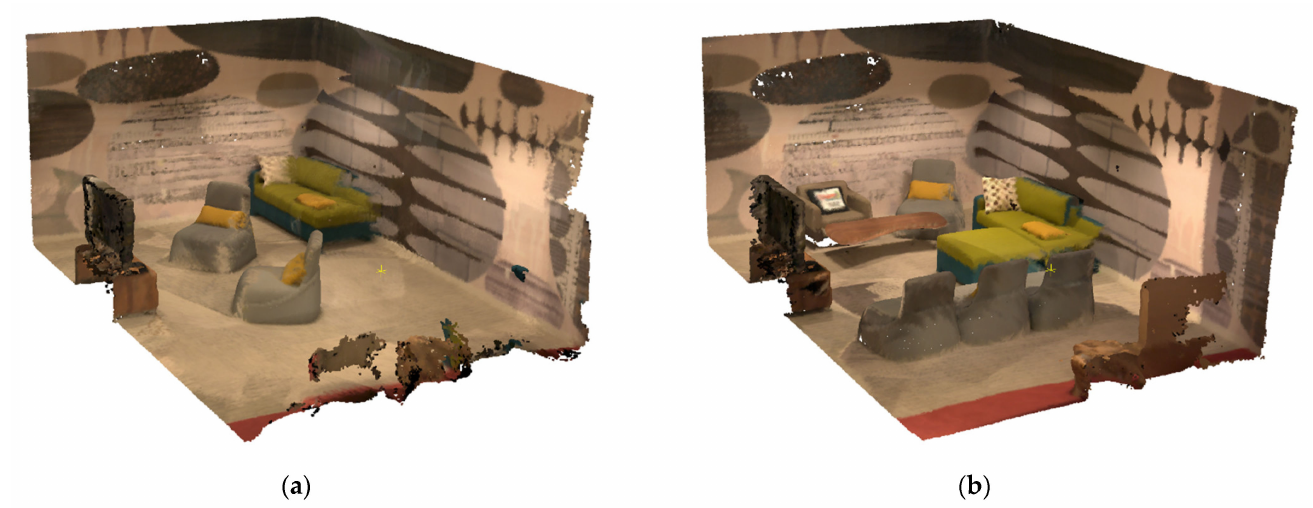
Figure 14. Observations at two epochs (( a ) and ( b )) of the living room (controlled environment). PLS dataset of Kijkduin beach–dune. A high-resolution 4D terrestrial laser scan